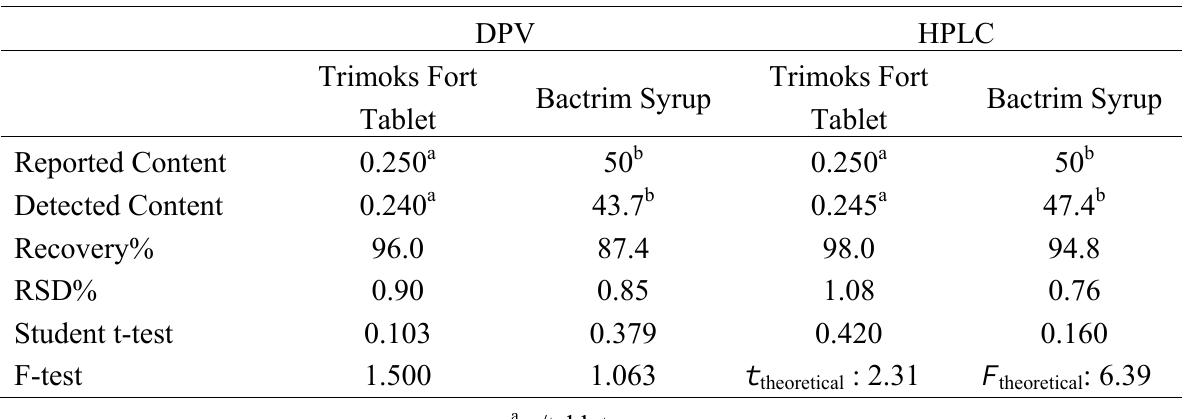
Table 2. Determination of sulfamethoxazole in pharmaceutical preparations using DPV at molecularly imprinted polypyrrole modified pencil graphite electrode and